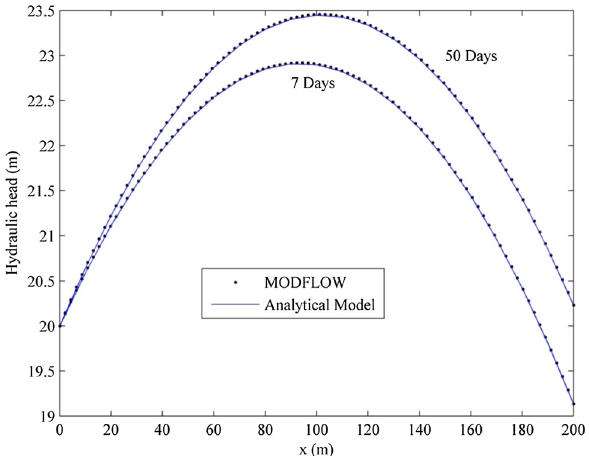
Fig. 6 Flow rate variations at the left and right